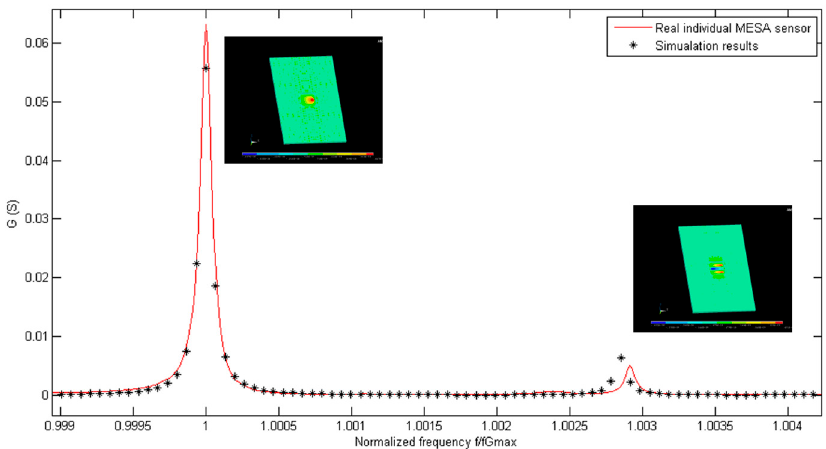
Figure 6. Comparison of the real part of the electrical admittance (G) measured in air of a manufactured AWS HFF-QCM sensor, and the response provided by the numerical model.